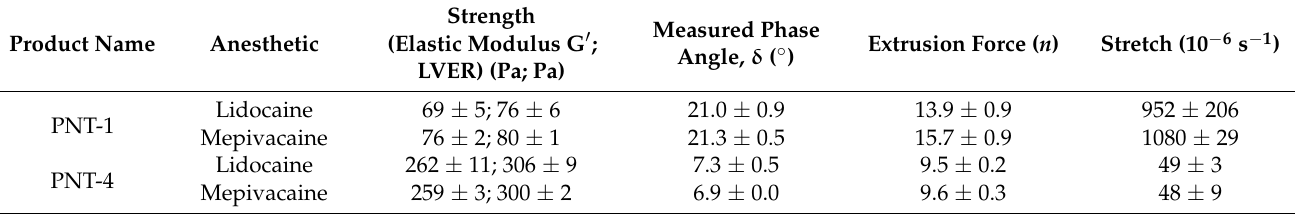
Table 2. Mechanical properties of the investigated gels.